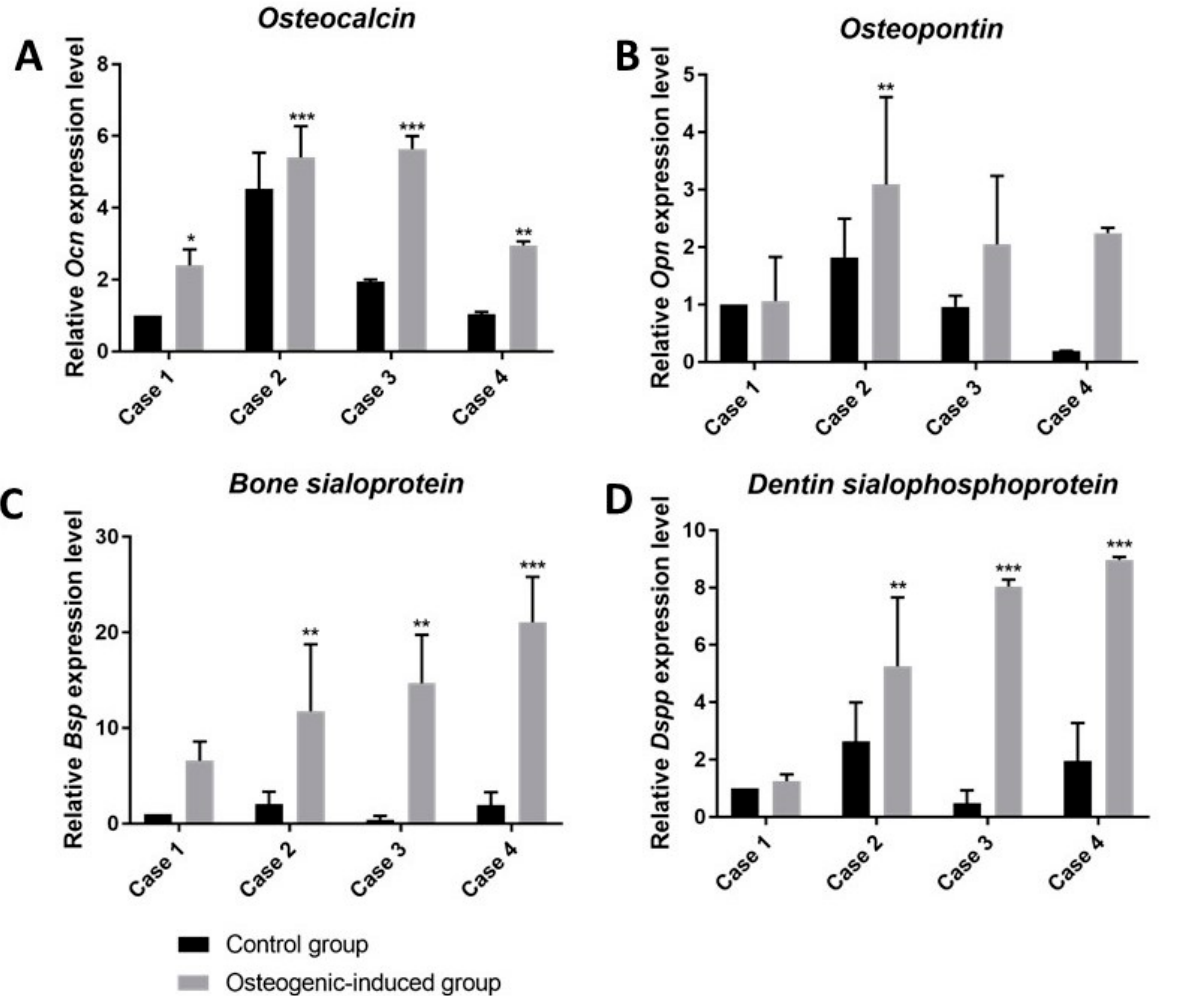
Figure 11. Real-time PCR analysis of the bone-related genes in osteogenic induced hDPSCs-PLCL construct ( n = 4) and undifferentiated hDPSCs-PLCL (control group, n = 4). ( A ) Osteocalcin ( OCN ) was significantly upregulated in all cases compare to control group (* p < 0.05, ** p < 0.005, *** p < 0.0001). ( B ) Osteopontin ( OPN ) expression significantly increased in one cases (** p < 0.005). ( C ) Bone sialoprotein ( BSP ) and ( D ) Dentin sialophosphoprotein ( DSPP ) genes were significantly upregulated in three of four hDPSCs/PLCL constructs (** p < 0.005, *** p < 0.0001).